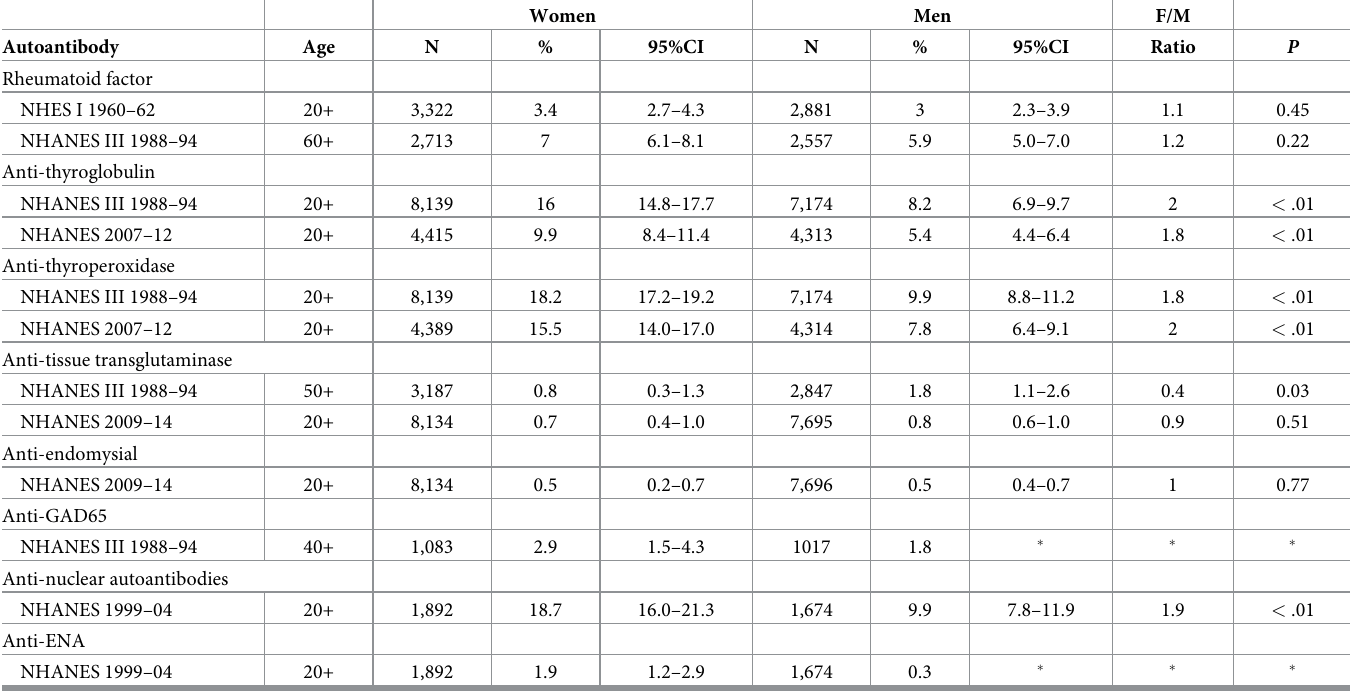
Table 4. US autoantibody prevalence by sex, NHANES